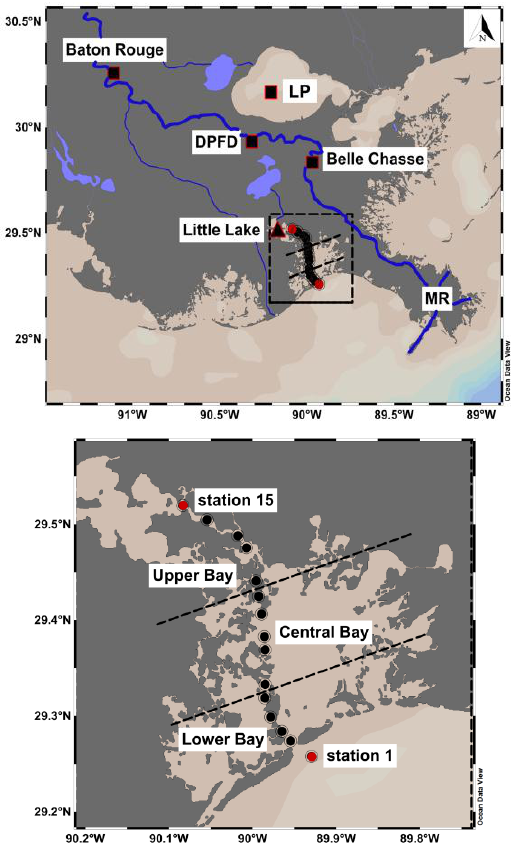
Figure 1. Barataria Bay, Louisiana, USA. Sampling stations are plotted along the transect from the marine end member (Station 1) to the freshwater end member (Station 15). The black squares represent the approximate locations of the Davis Pond Freshwater Diversion (DPFD), Baton Rouge, and Belle Chasse; Little Lake is represented by a triangle. MR is the Mississippi River and LP is Lake